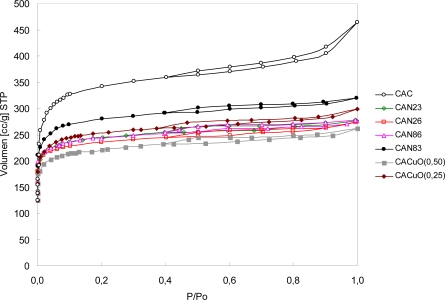
N2 adsorption isotherms at 77 K.